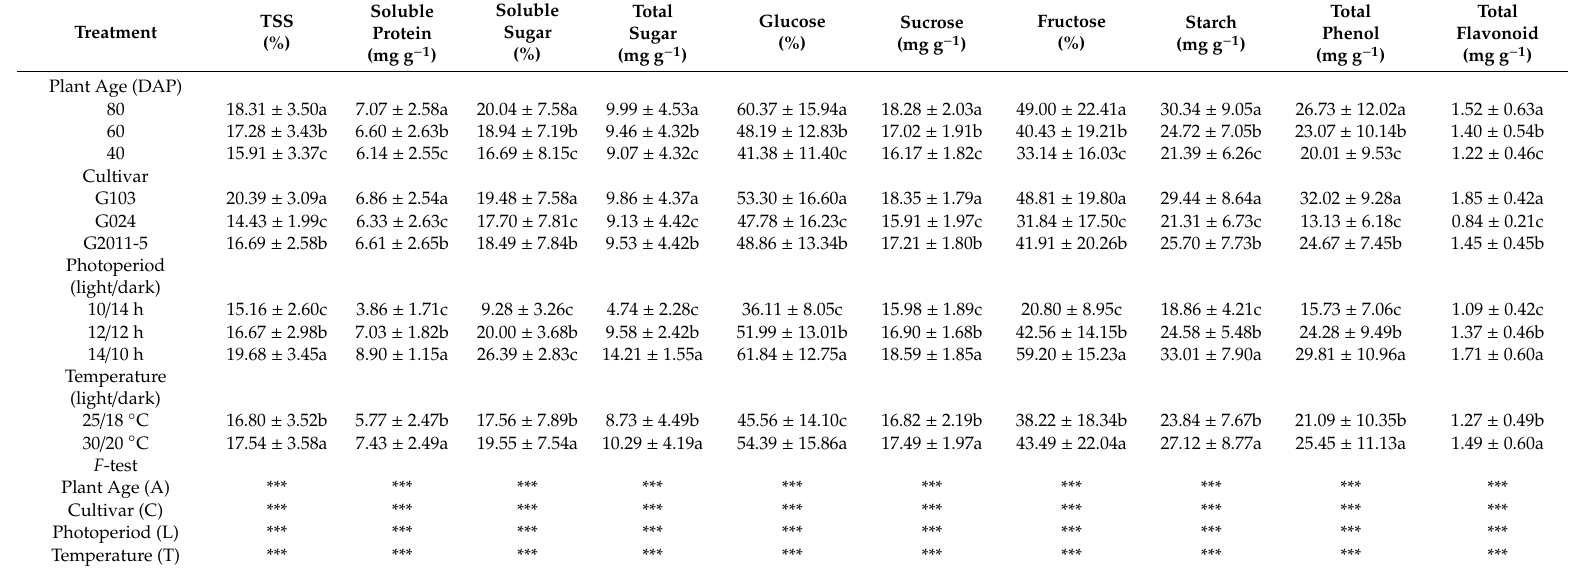
Table 4. E ff ect of plant age, cultivar, photoperiod and temperature treatments on garlic bulb physiological and nutritive quality traits.